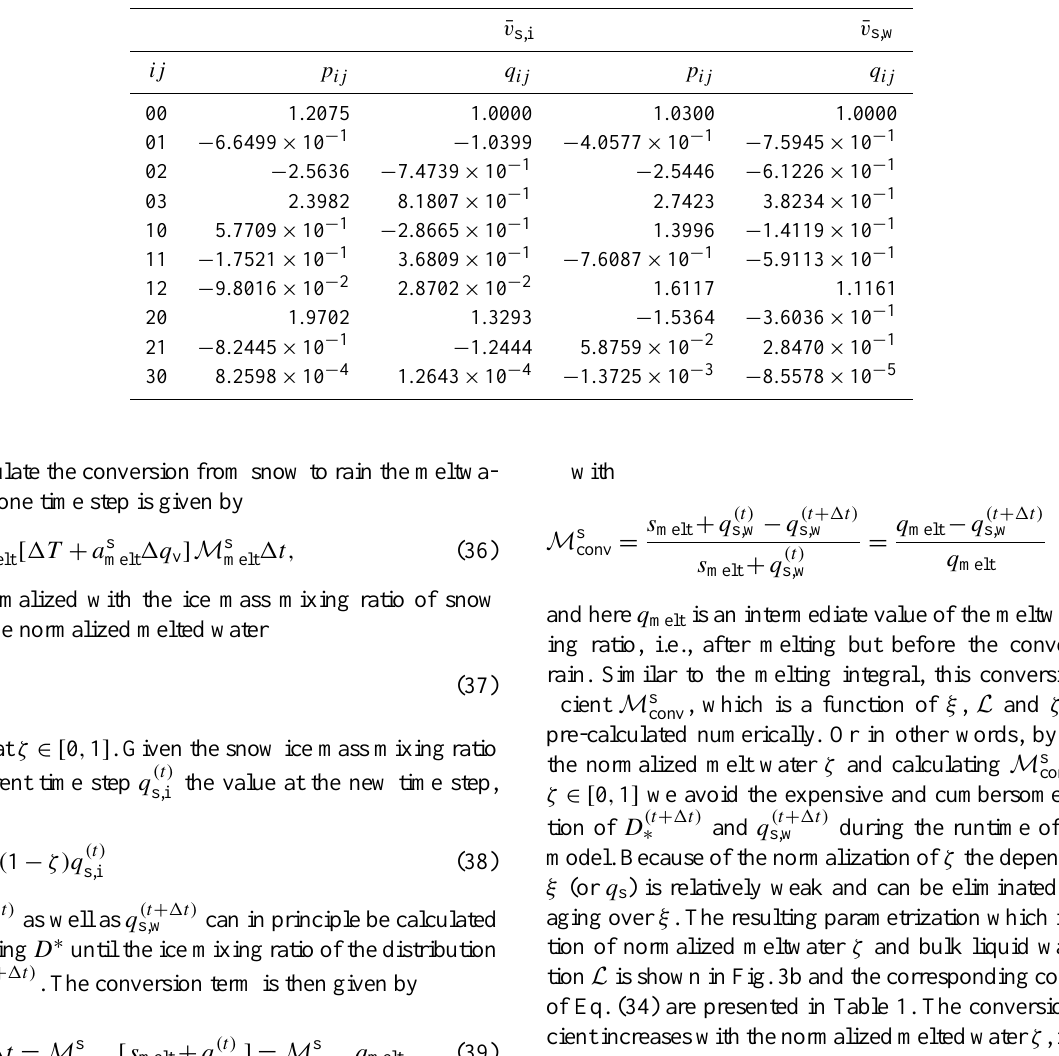
Table 2. The coefficients used within the Pade-type rational function (Eq. 34) for the two sedimentation